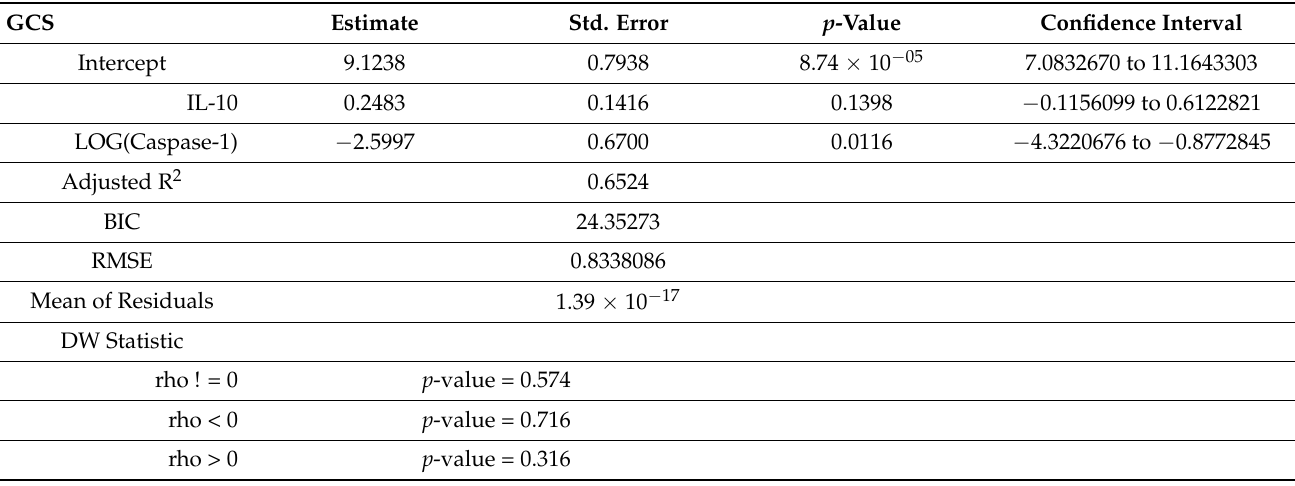
Table 4. Linear Regression Model to predict